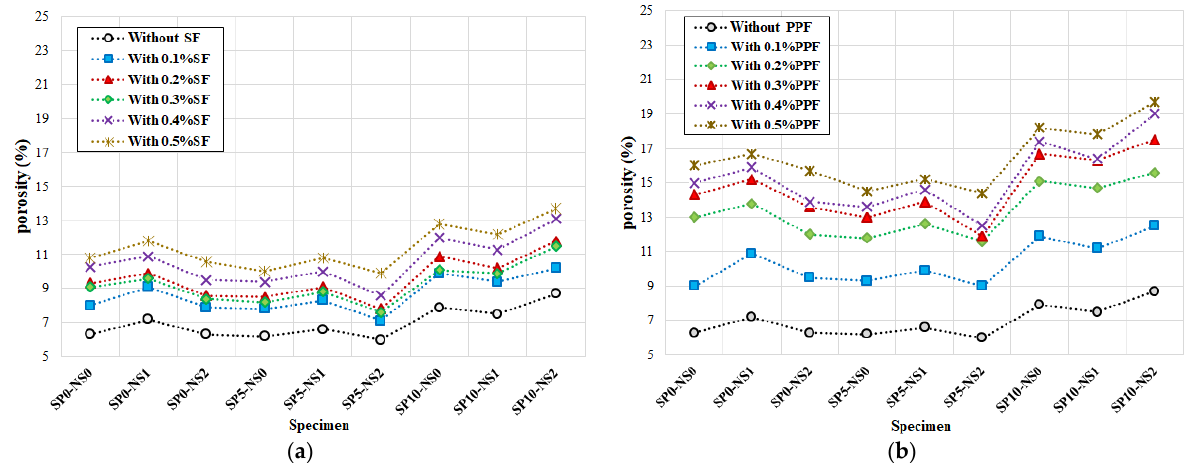
Figure 19. Effect of the fibres on the porosity of HSC containing NS and SP ( a ) SF and ( b ) PPF.